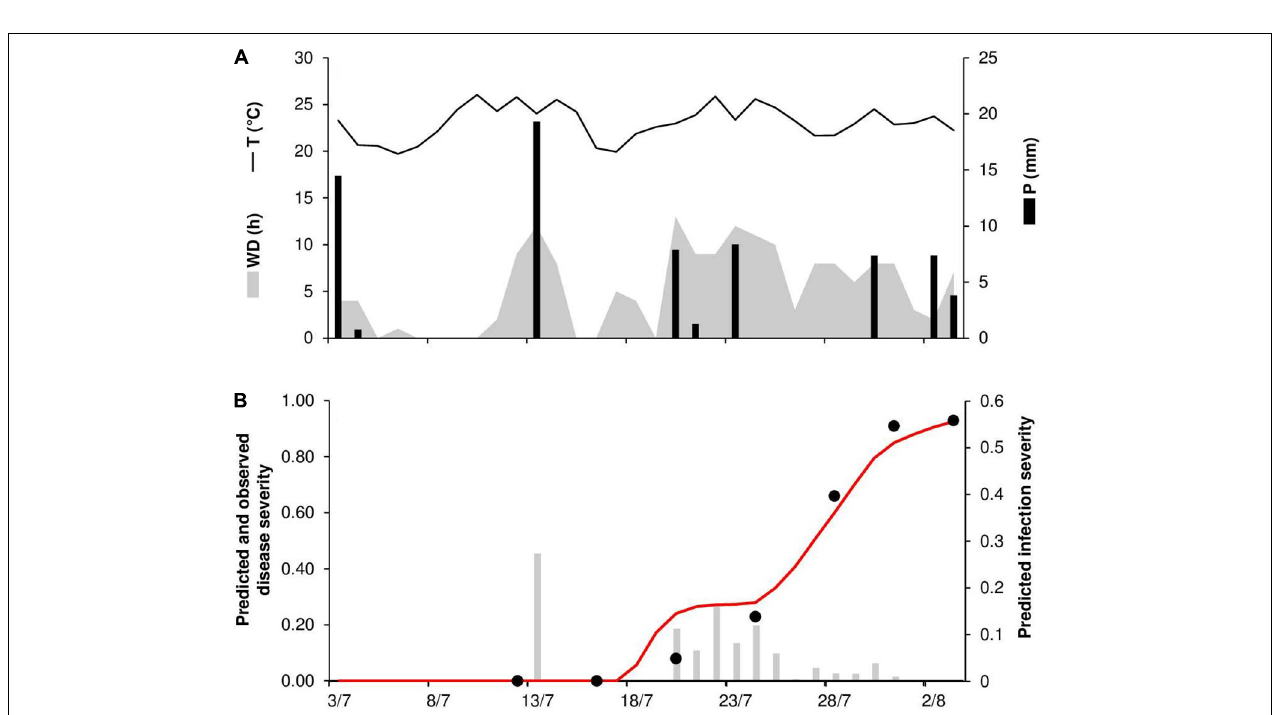
FIGURE 9 | Predicted and observed stem rust progress in the experimental wheat field (susceptible cv. Prelude) in St. Paul, MN, United States, in 1979 (STP79). (A) Weather variables: air temperature (T, ◦ C, solid line), rainfall (R, mm, black bars), and wetness duration (WD, in h, gray area). (B) Infection severity predicted by the model (gray bars), disease severity predicted by the model (red line), and observed disease severity (full